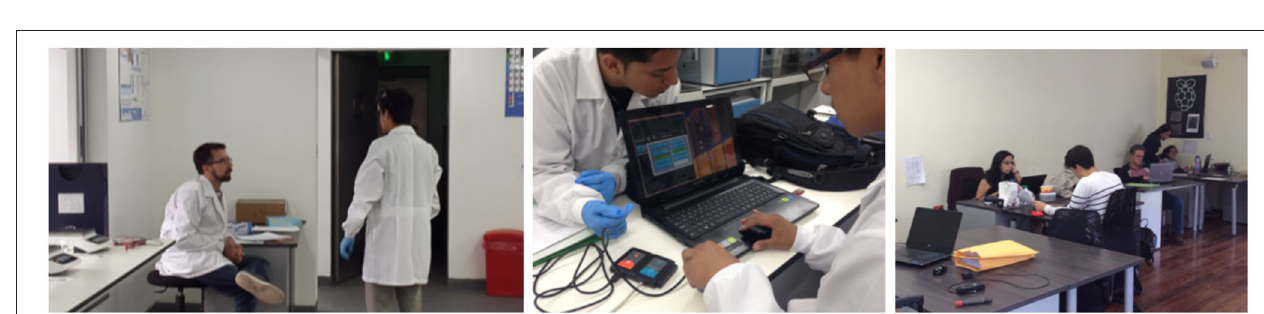
FIGURE 2 | Objects in academic spaces (offices, laboratories, and field works).